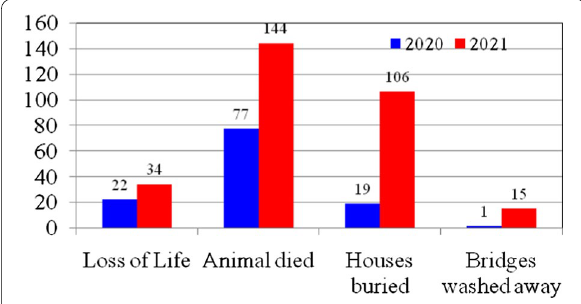
Fig. 3 Loss of human lives, livestock, houses and bridges due to cloudburst in Uttarakhand during the 2020 and 2021